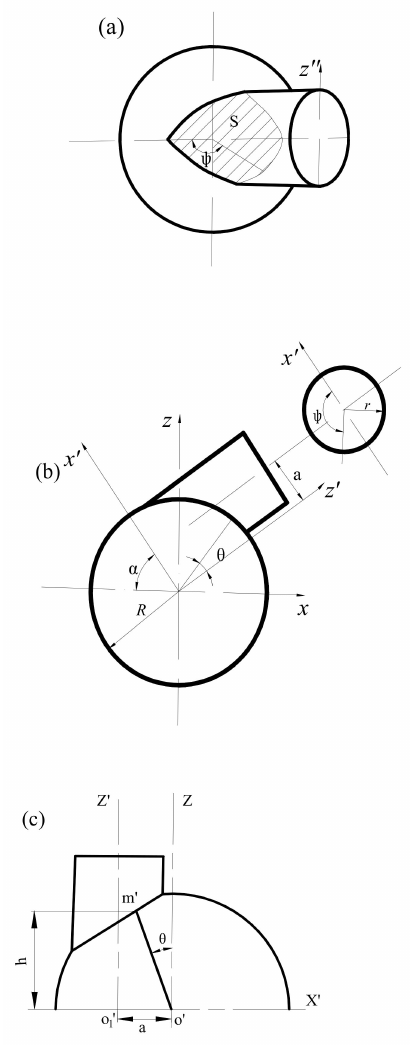
Figure 3. The cylinder passing through the sphere without crossing its centre: ( a ) the relative position between cylinder and sphere, ( b ) the side view of the model, ( c ) the model after rotating on the Z